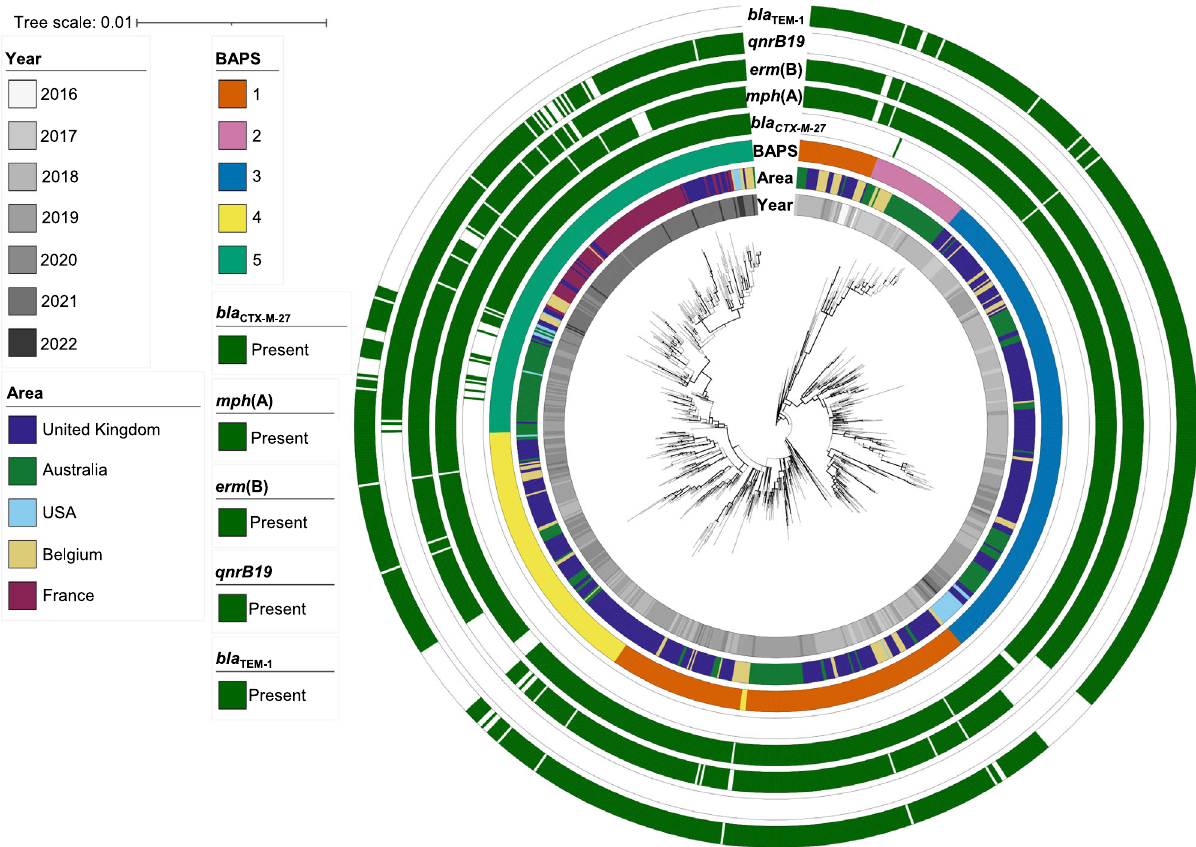
Fig. 2 | The evolution and international spread of MSM-associated XDR S. sonnei . A midpoint rooted maximum likelihood phylogenetic tree shows the dis- tribution of UK isolates (belonging to both CipR.MSM5 and the t10.377 outbreak cluster, n =468) and relevant related international isolates belonging to CipR.MSM5(SupplementaryFig.1, n =475).Metadatatracksshowyearandcountry